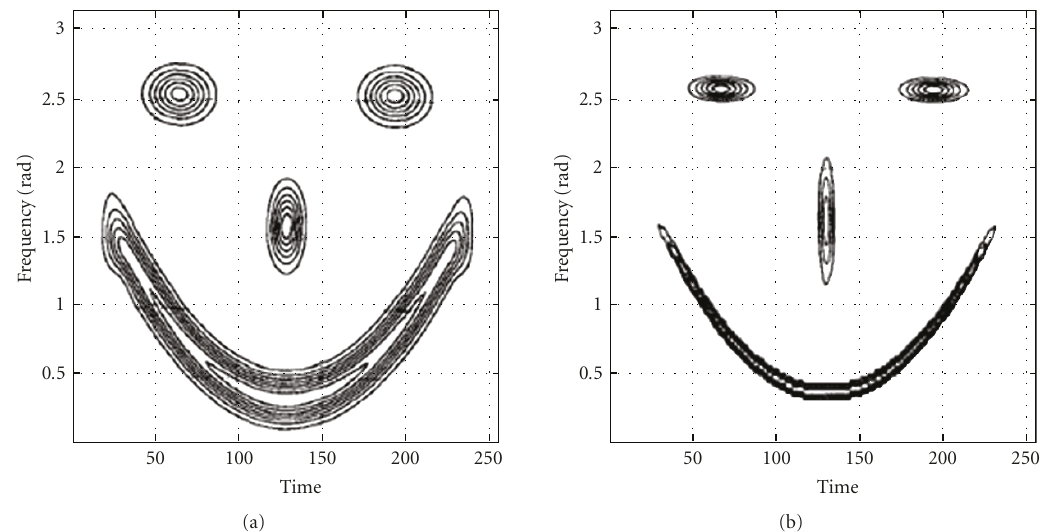
Figure 2: Example 2. A smiling face signal composed of a quadratic FM component, two sinusoids at di ff erent time periods, and a Gaussian function shifted in frequency, (a) initial ES estimate of the signal, (b) the final ES estimate (adopted from Akan